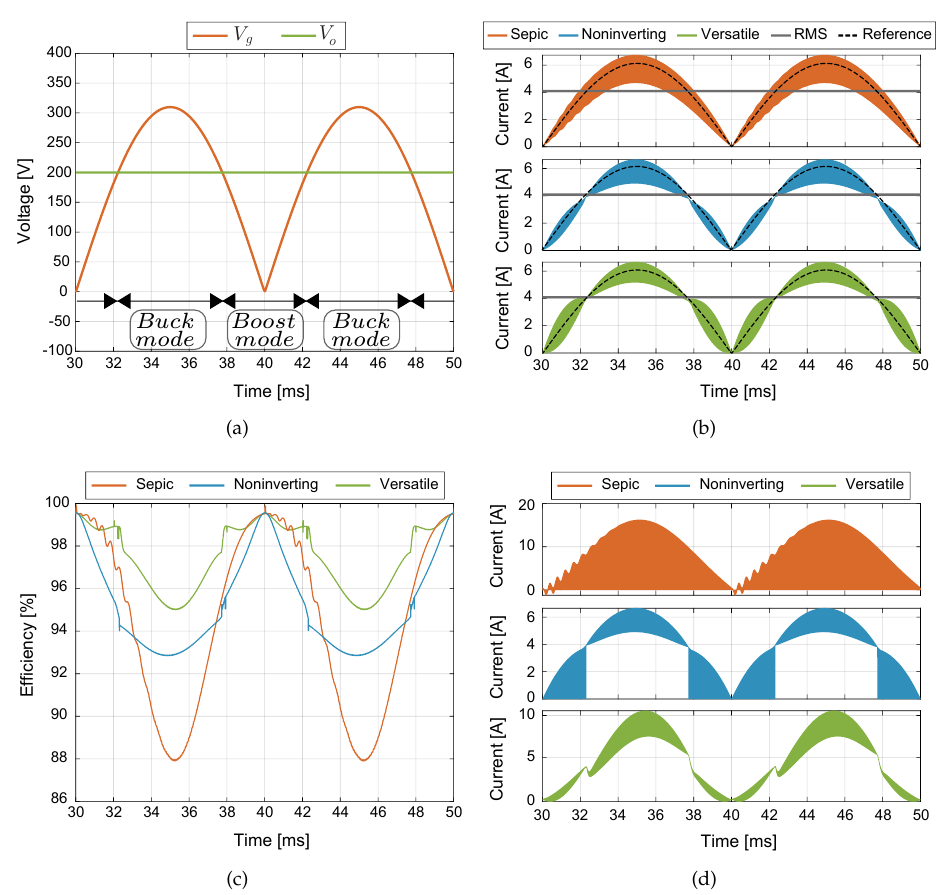
Figure 7. PLECS thermal simulation: ( a ) input and output voltage waveforms, ( b ) current control waveforms, ( c ) AC-DC conversion efficiency results over one period of the grid signal (20 ms), ( d ) output current